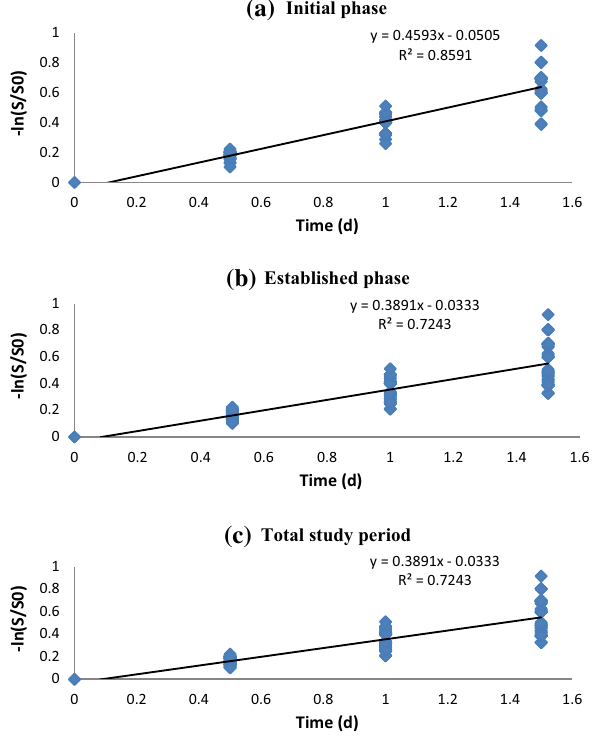
Fig. 4 Computation of overall K removal Table 6 Performance of reaction kinetic models and estimated reac- tion parameters